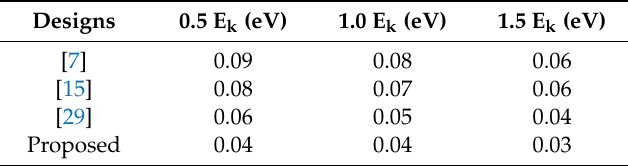
Table 7. Energy dissipation analysis at T = 2 K.